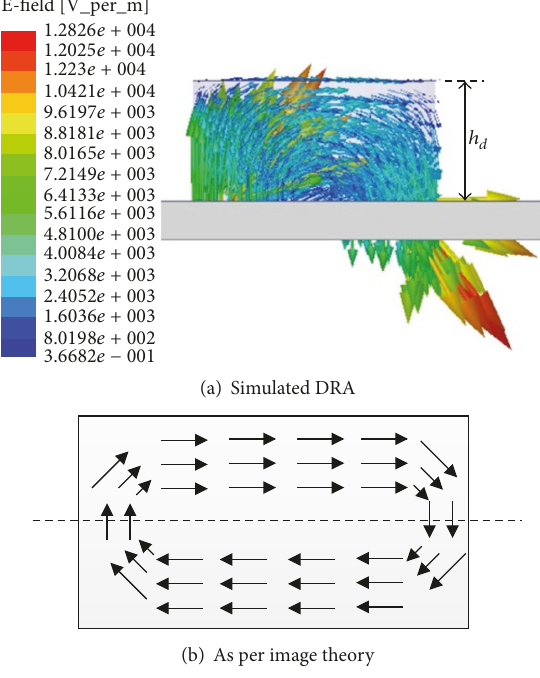
Next, the different development stages of the antenna design are discussed in respective subsections.